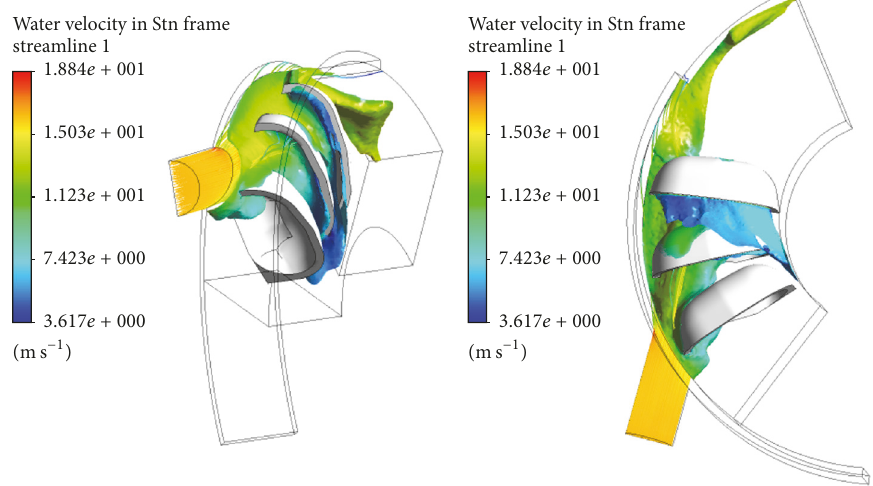
Figure 10: Flow visualization of the baseline design, side views, and face views (PCD = 500 mm).